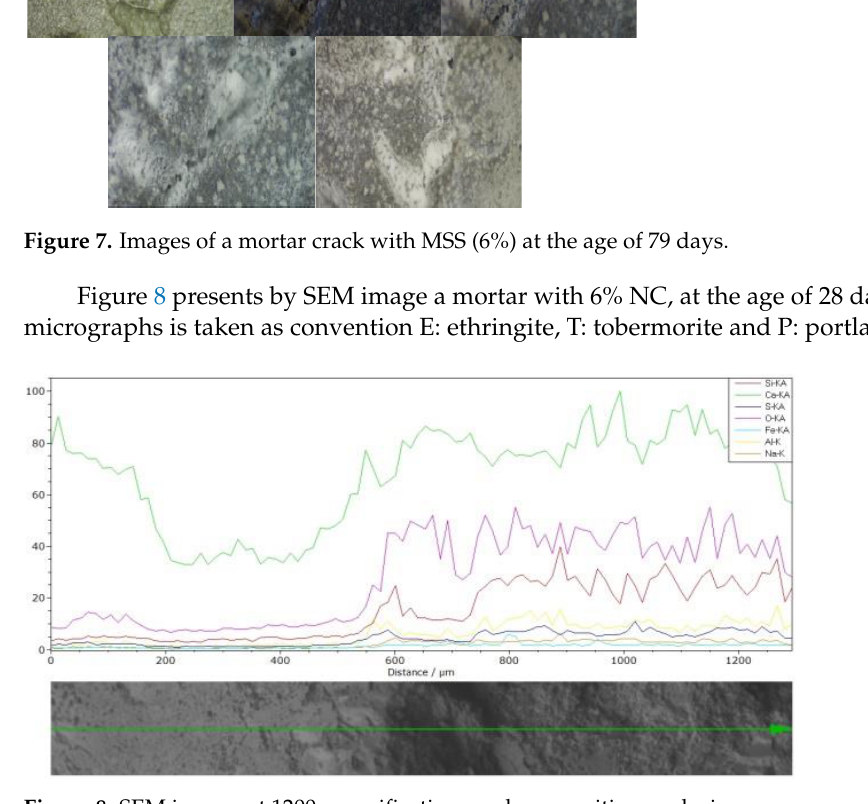
Figure 8. SEM images at 1200 magnifications and composition analysis .